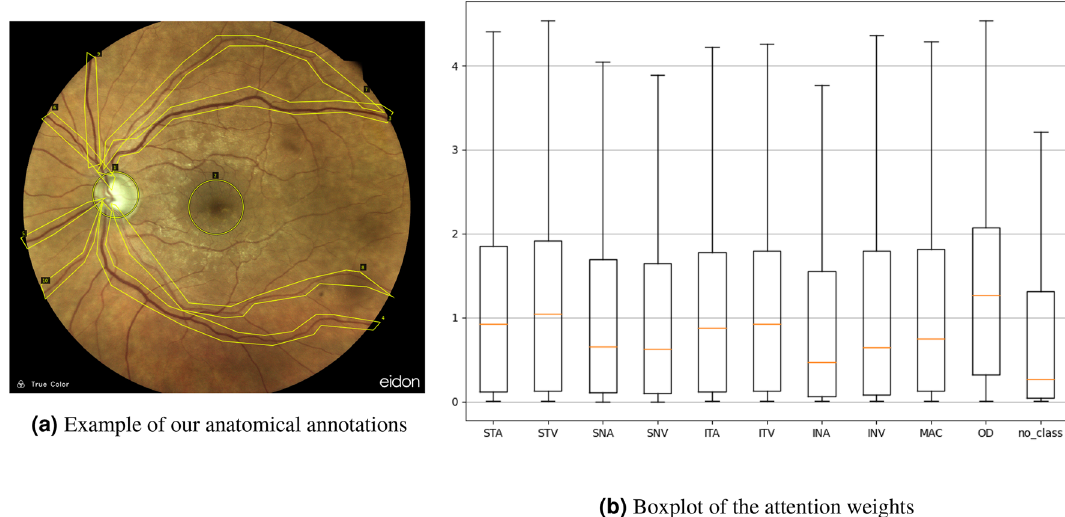
Figure 5. ( a ) Is an example of the different anatomical structures that were annotated. ( b ) Shows boxplots of the attention weights according to the anatomical structure they are showing. Class legend: S/I superior/inferior, T/N temporal/nasal, A/V artery/vein, MAC macula, OD optic disc.